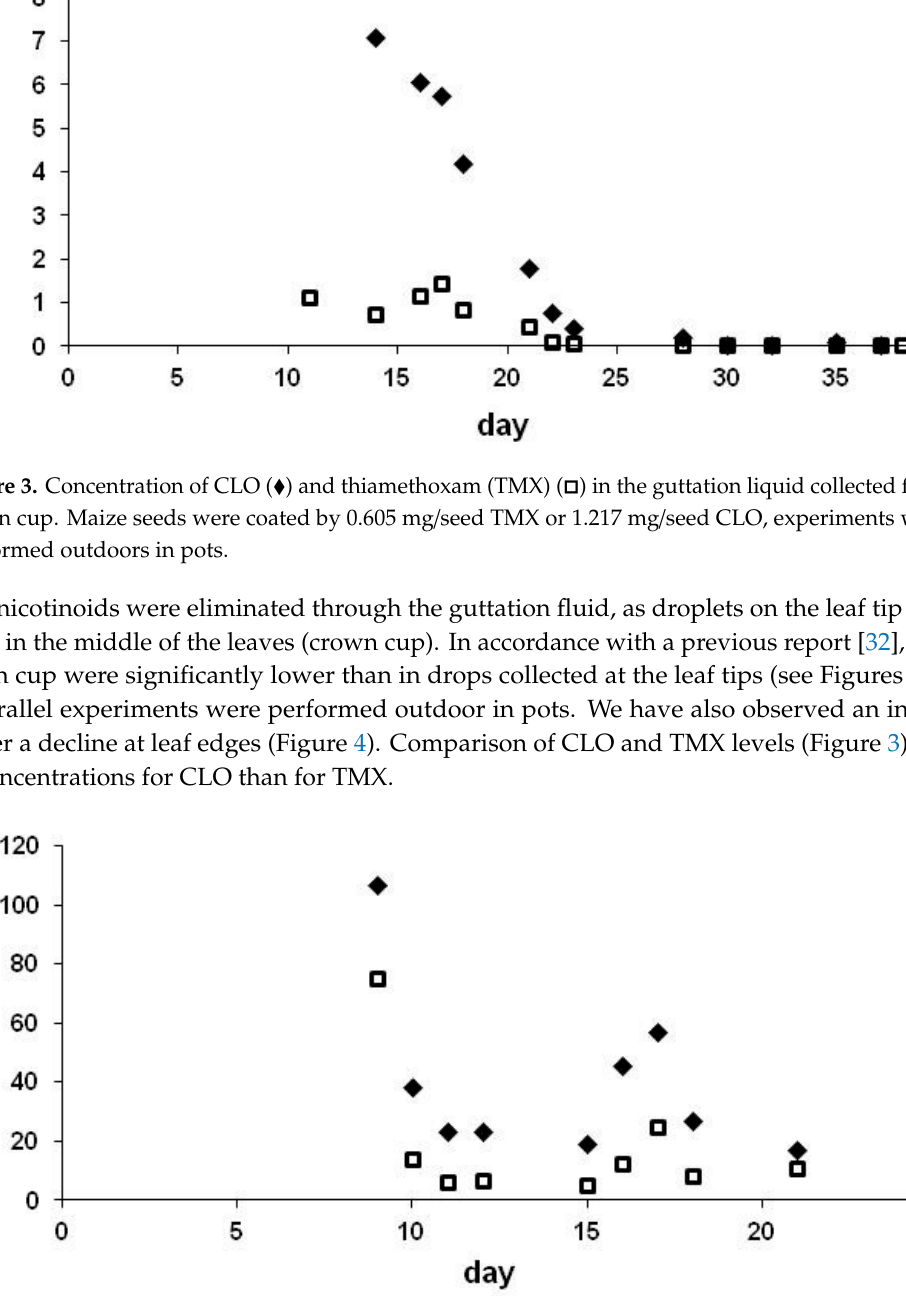
Figure 4. Concentration of CLO ( (cid:7) ) and TMX ( (cid:3) ) in the guttation liquid collected at leaf edges of maize plants. Maize seeds were coated by 0.605 mg / seed TMX or 1.217 mg / seed CLO, experiments were performed outdoors in pots.